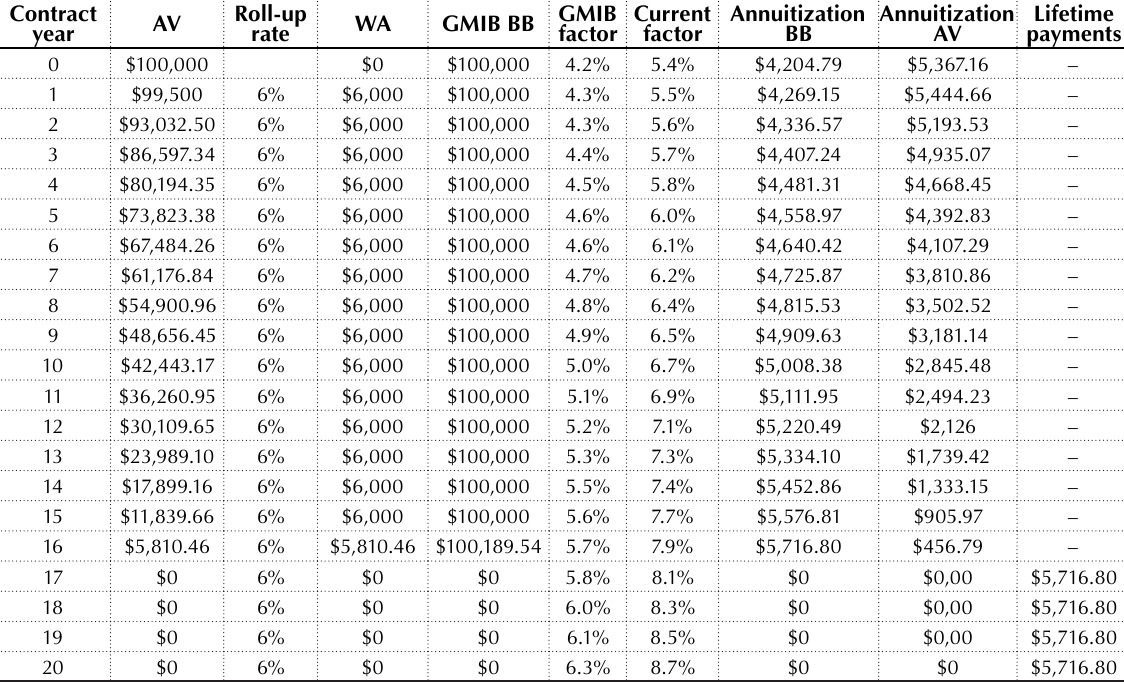
Table 2. Protected account value and GMIB behavior given a static withdrawals strategy and lifetime payments